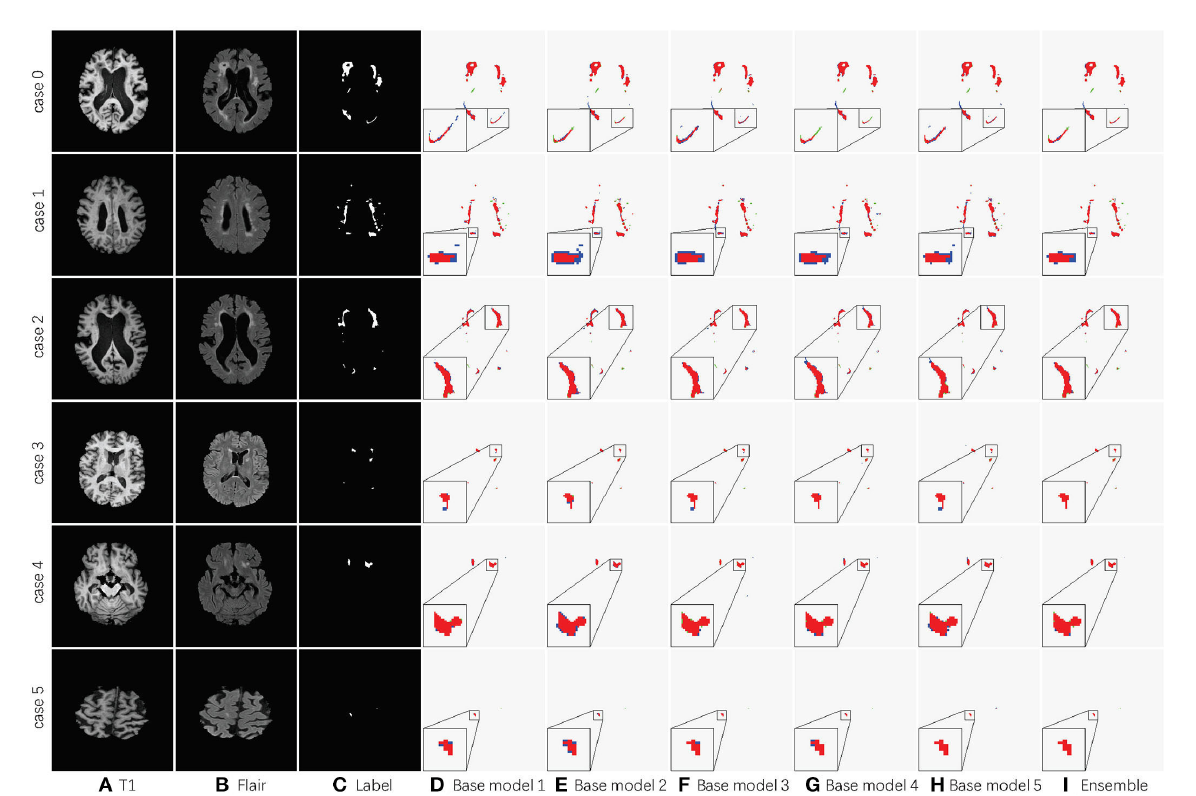
FIGURE6 Detailed segmentation results of five base models and the ensemble. (A) T1 image; (B) Flair image; (C) Label; (D) Base model 1; (E) Base model 2; (F) Base model 3; (G) Base model 4; (H) Base model 5; (I) Ensemble. The red area in columns Base model 1, Base model 2, Base model 3, Base model 4, Base model 5, and Ensemble is the overlap between the segmentation result and label. The blue ones are the prediction errors. For better visualization, the regions inside the smaller yellow bounding box are zoomed into the larger bounding box.